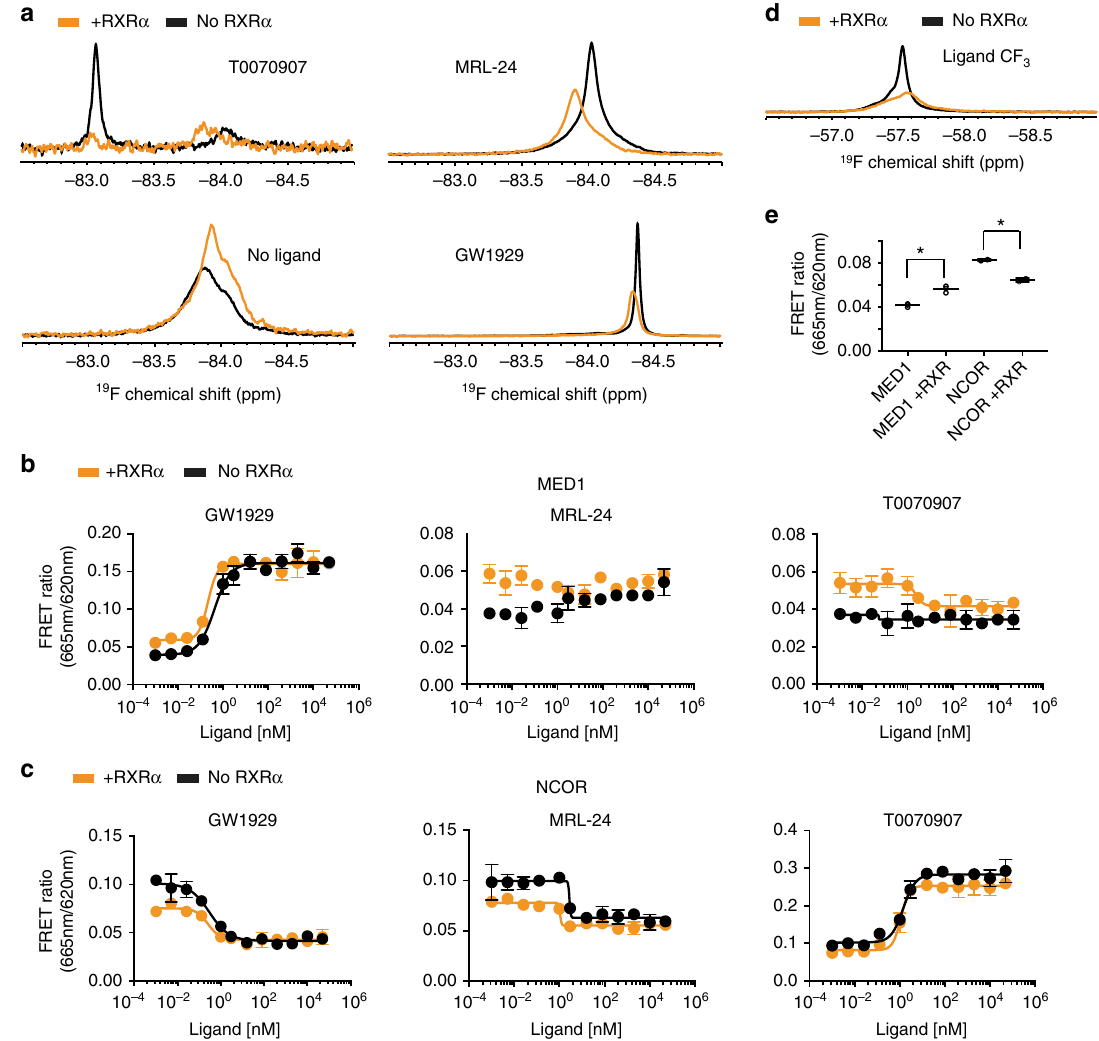
Fig. 8 Heterodimerization of PPAR γ LBD with RXR α LBD favors coactivator binding. a 19 F NMR of PPAR γ K502C -BTFA bound to T0070907 and PPAR γ C313A,502C -BTFA bound to MRL24 or GW1929 or with no ligand bound was performed in the presence (orange) or absence (black) of RXR α LBD. These experiments were performed once. d The 19 F NMR signal from the MRL24 ligand. Broadening and consequent reduction in signal intensity is expected as a consequence of the increased rotational correlation time of the heterodimer complex. b , c TR-FRET was used to measure interaction between wt PPAR γ LBD and MED1 or NCoR in the presence or absence of equimolar concentrations of RXR α . Error bars represent standard deviation of two technical replicates within a single experiment. The experiment was repeated twice and gave similar results each time. e Heterodimerization favors MED1 binding ( p = 0.0017) and disfavors NCoR binding ( p = 0.0076) to apo PPAR γ . In addition, visual and statistical comparison of NCoR and MED1 recruitment to PPAR γ LBD saturated with ligand (four highest concentrations of ligands) indicates that RXR α affects co-regulator recruitment to T0070907-bound PPAR γ (NCoR, p = 0.0042; MED1, p = 0.0027) more than GW1929 (NCoR, p = 0.44; MED1, p = 0.34) or MRL24 (NCoR, p = 0.0141; MED1, p = 0.061). All p values are derived from a two-tailed t